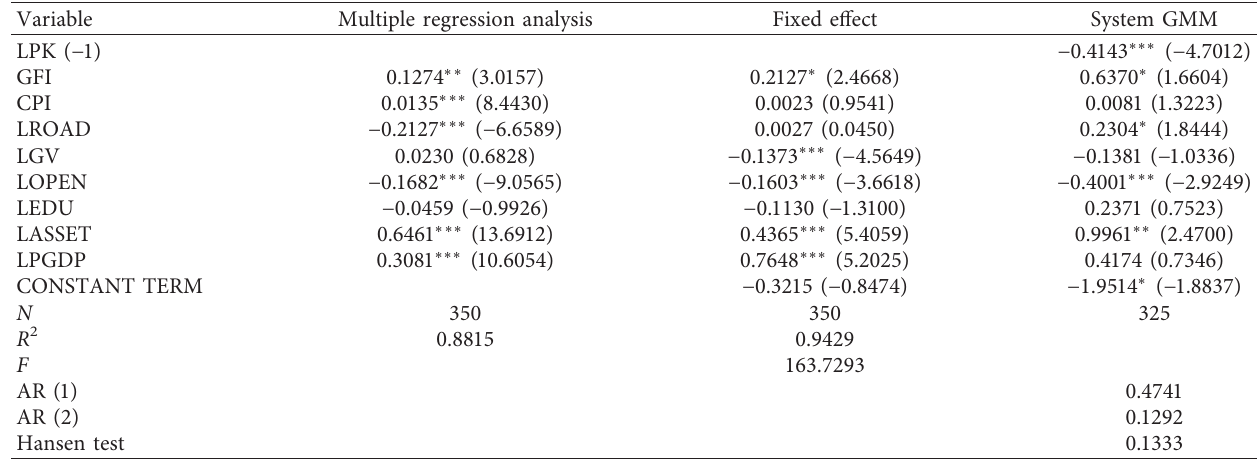
Table 7: Regression analysis of the impact of green financial development on poverty